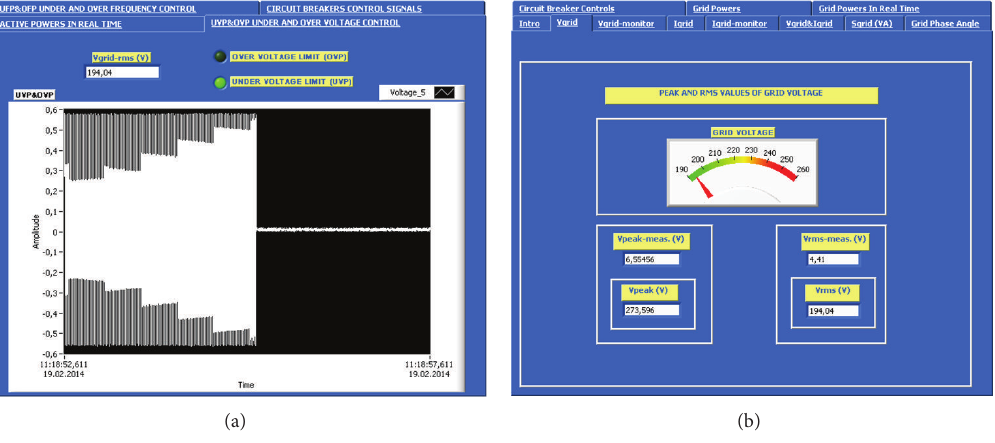
Figure 27: Software interface for under voltage condition.